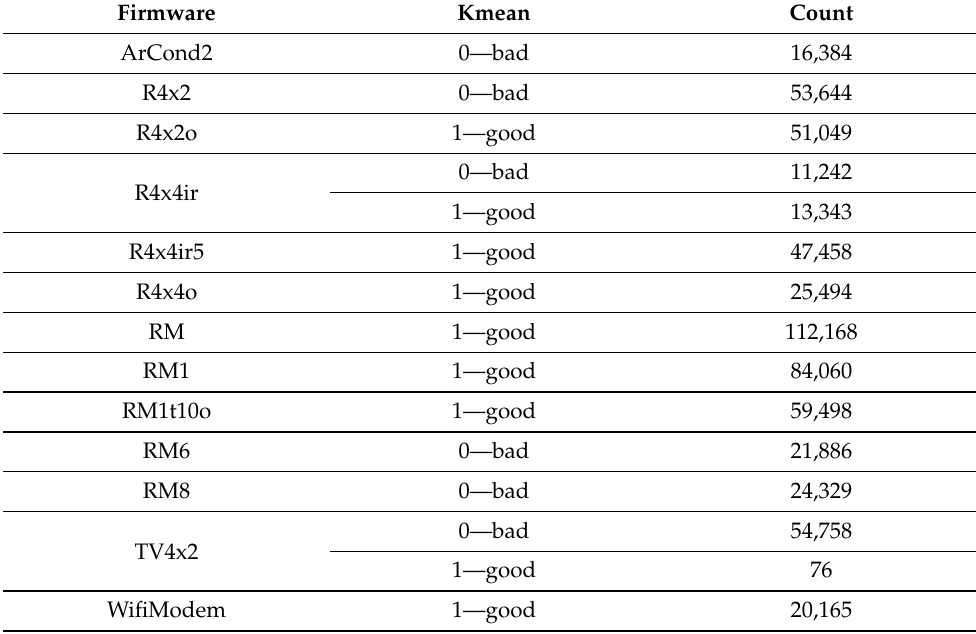
Table 4. Smart home ESP8266 clustering